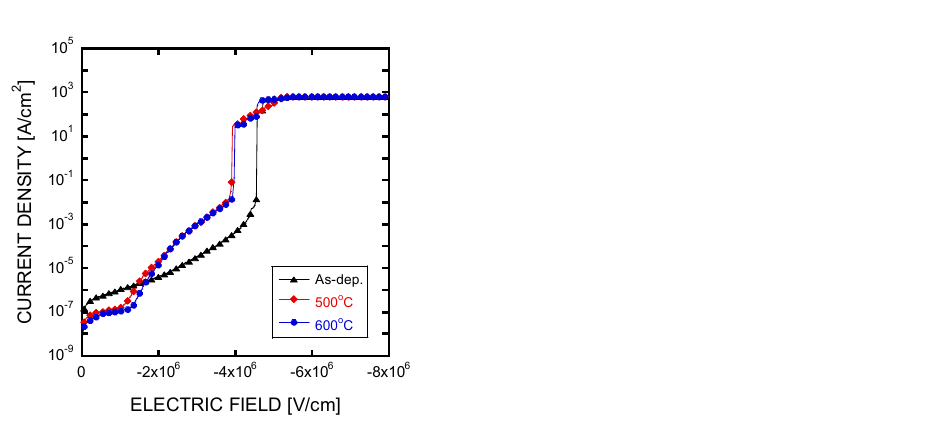
Figure 8. UV–visible spectrophotometric analysis of ALD-deposited ZrO 2 thin films (deposition temperature: 150 °C, CMEN-Zr pulse time: 2.5 s, O 2 plasma pulse time: 9 s, PEALD cycle: 350 cy- cles (~30 nm), substrate: borosilicate glass).